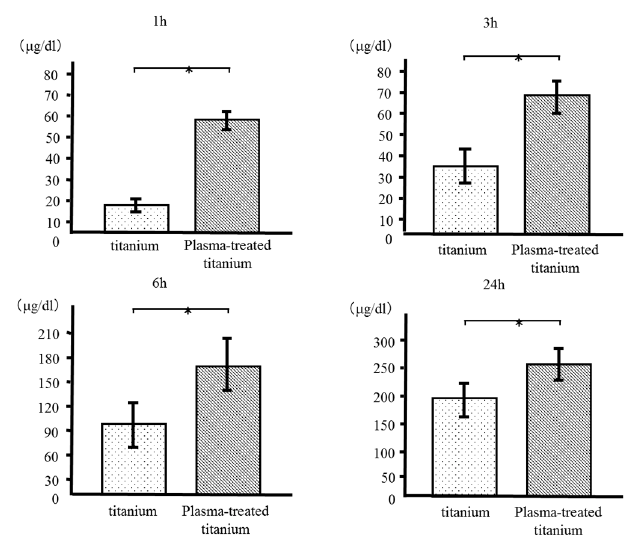
Figure 5. Bovine serum albumin (BSA) adsorption of titanium and plasma-modified titanium. More BSA was adsorbed to the plasma-treated than the titanium disks at every time point.